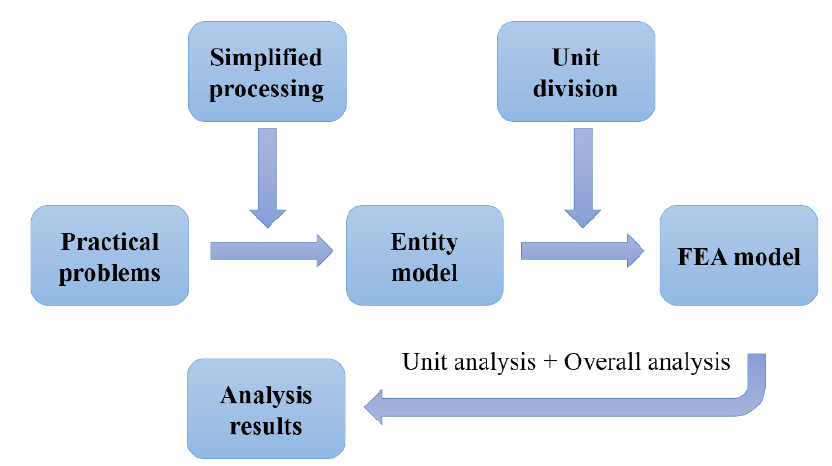
Figure 2. The finite element analysis process.